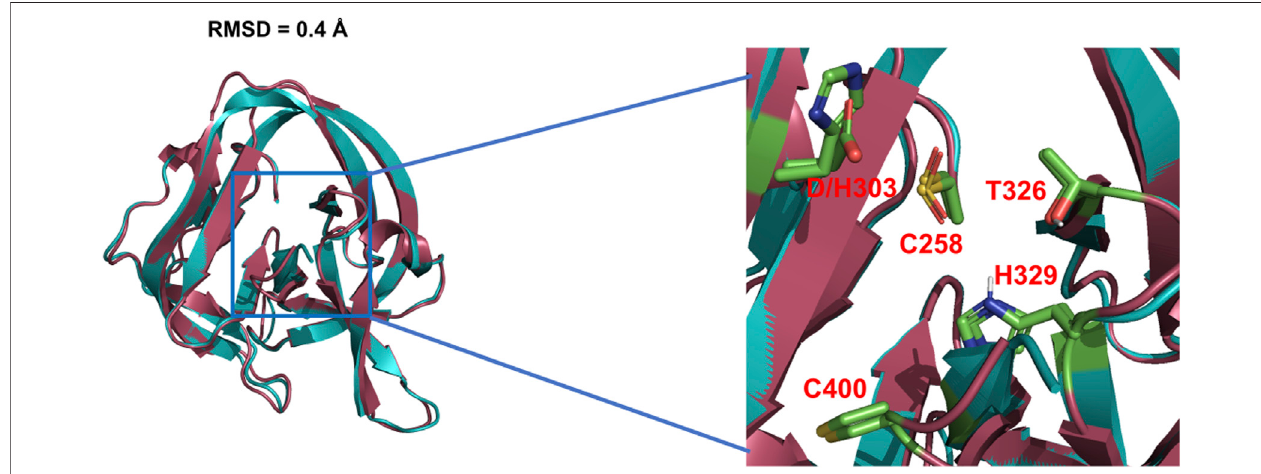
FIGURE6| 3DstructuresofWTHhHintandD303H.Crystalstructures ofWTHhHintdomain(red,PDB:1AT0)andD303H(cyan,PDB:6TYY)arealmostidentical (RMSD = 0.4 Å). The right image shows a magni fi ed region of the conserved residues in the active site of WT and D303H.